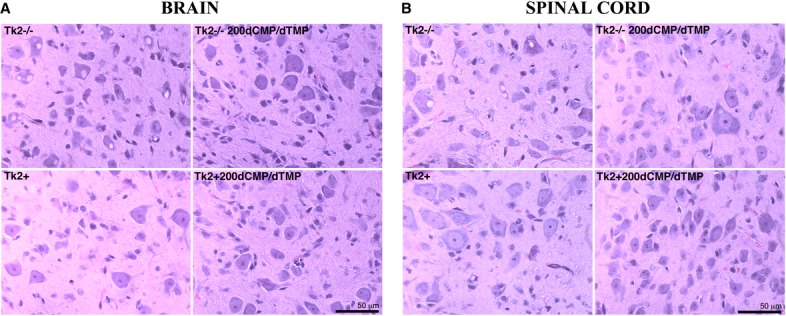
dCMP/dTMP effects on brain and spinal cord morphologyA, B   Hematoxylin and eosin stain showing numerous vacuoles in 13-day-old untreated Tk2−/− in brain (A) and spinal cord neurons (B). Vacuoles were rare or absent in Tk2−/−200dCMP/dTMP and not observed in wild-type mice.